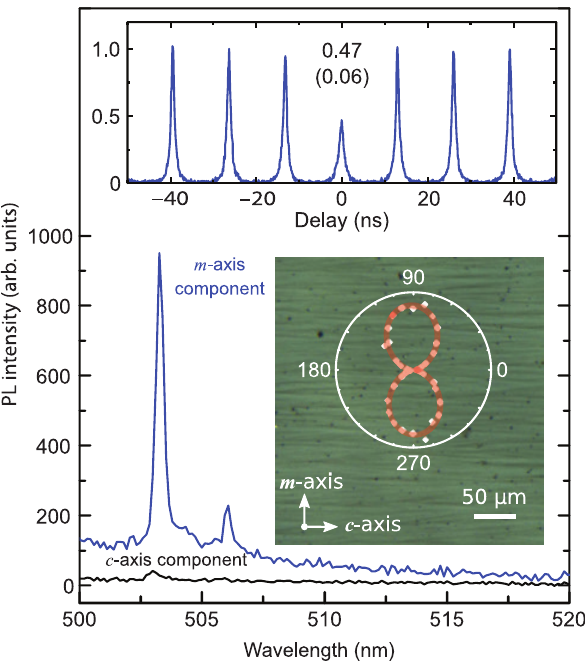
Figure 3: The μ -PL of the two cross-polarized components for a QD at 503 nm ( ~ 2.46 eV). Top inset demonstrates the emission of single photons with a raw g (2) (0) of 0.47, which becomes 0.06 after a standard background correction ( ~ 75% QD intensity). Right inset shows sinusoidal intensity variation of the QD emission and axis of polarization with respect to striations on the sample